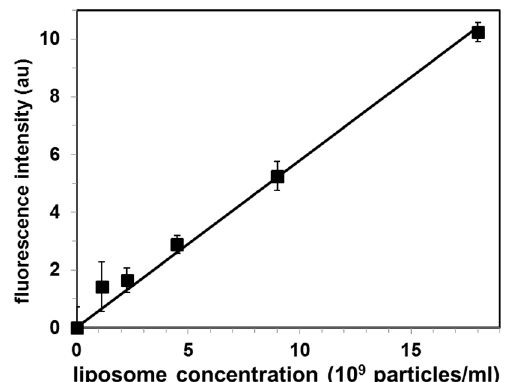
Figure 4. Calibration curve for quantification of exosomal liposomes by the proposed Cholera toxin subunit B (CTB)-gel filtration method. Values are mean ± SE of 3 independent experiments. Fluorescence intensity is in arbitrary units (au).